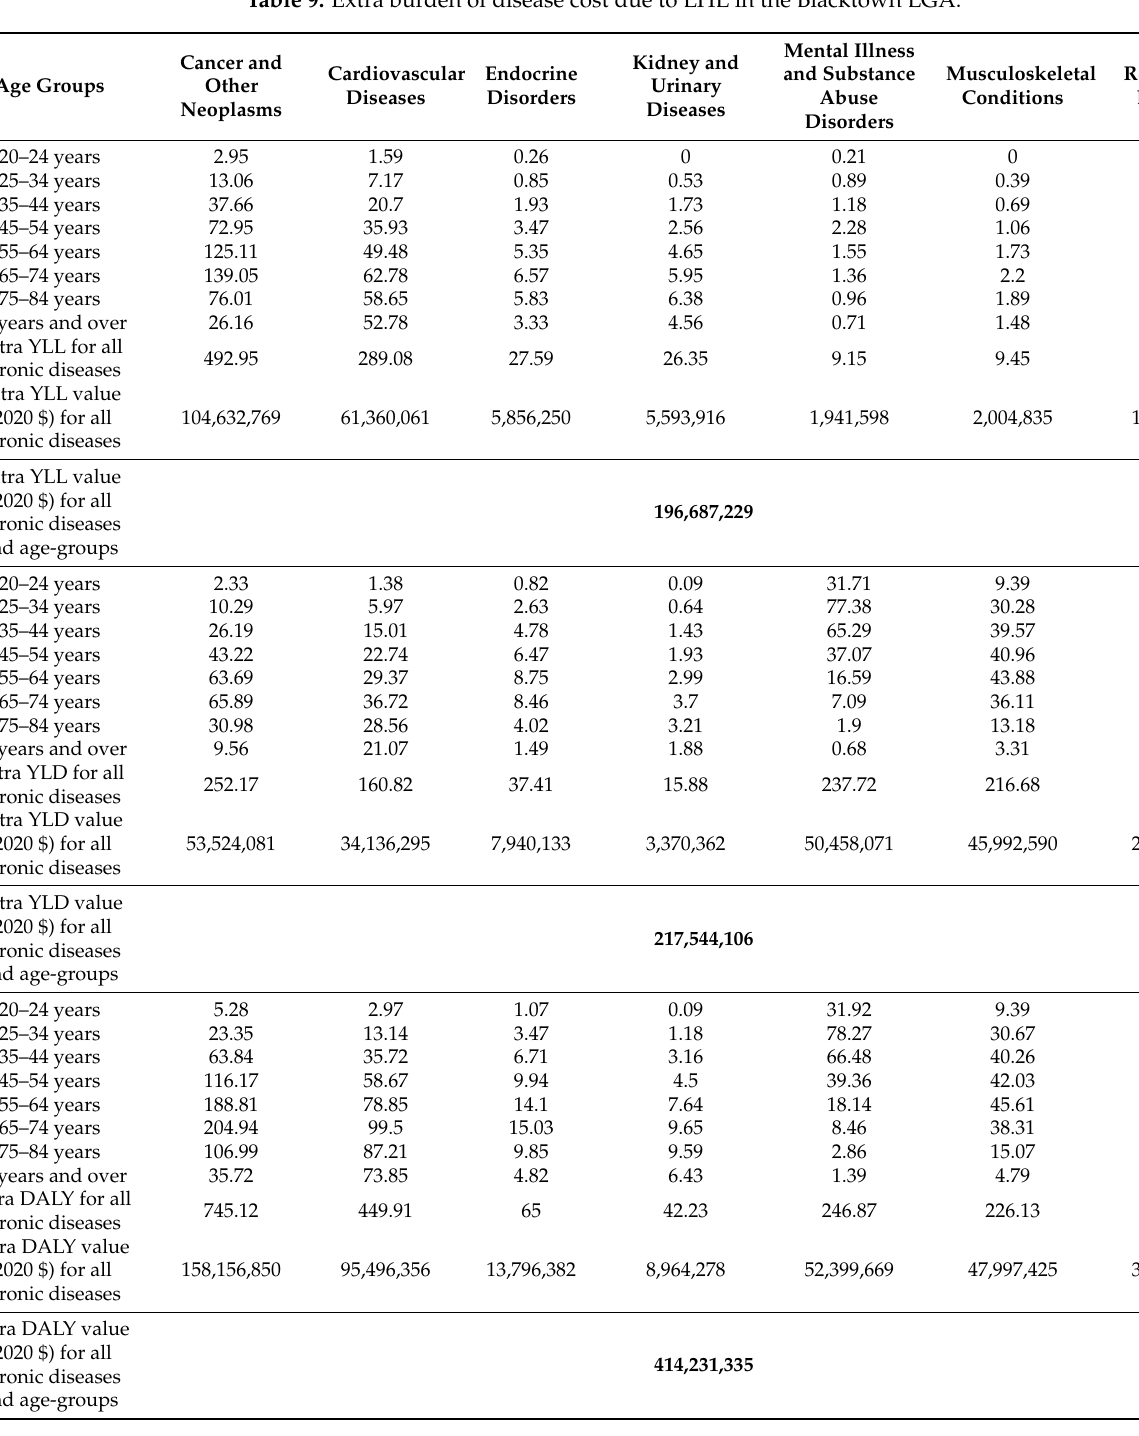
Table 9. Extra burden of disease cost due to LHL in the Blacktown